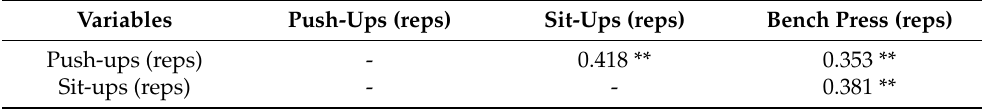
Table 3. Correlations between Muscular Endurance Variables at Week 1. Variables Push-Ups (reps) Sit-Ups (reps) Bench Press (reps) Push-ups (reps) - 0.545 ** 0.450 ** Sit-ups (reps) - - 0.360 **